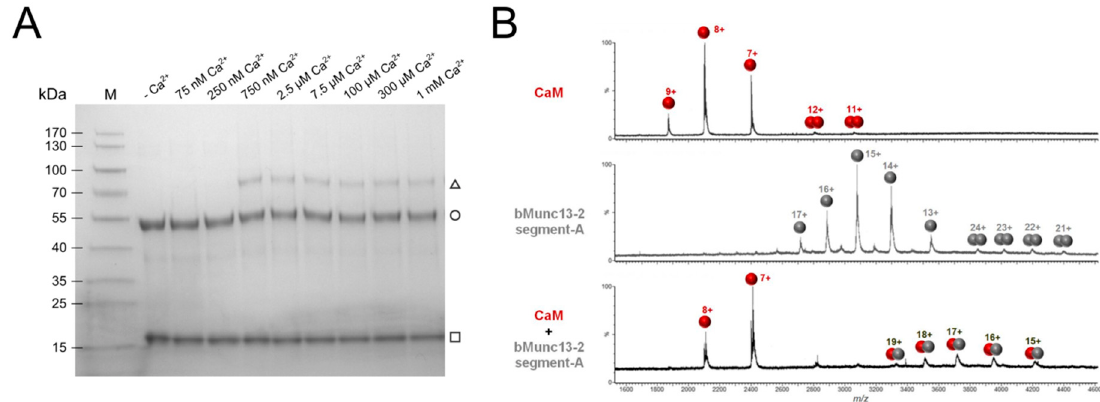
Figure 2. Ca 2+ -dependent complex formation between CaM and bMunc13-2 segment-A. ( A ) Gradient (4-20%) SDS-PAGE gel illustrating cross-linking of the CaM/segment-A complex at various Ca 2+ concentrations (adjusted by an EGTA buffer system). Covalent fixation of the complex was achieved by cross-linking of photo-Met residues incorporated in CaM. Proteins are visualized by Coomassie staining. (M) Prestained Protein Ladder, ( □ ) CaM, ( ○ ) segment-A and ( ∆ ) CaM/segment-A complex. ( B ) Native MS mass spectra of CaM alone (upper panel), segment-A alone (middle panel) and a segment-A/CaM complex (lower panel). Proteins (10 µM) were applied in 300 mM ammonium acetate (pH 7) and measurements were performed on a high-mass Q-TOF mass spectrometer. MS data were acquired using a capillary voltage of 1.38 kV, a cone voltage of 180 V, and a collision energy of 60 V. Measurements were performed at residual Ca 2+ concentration known to be around 5 µM [55].